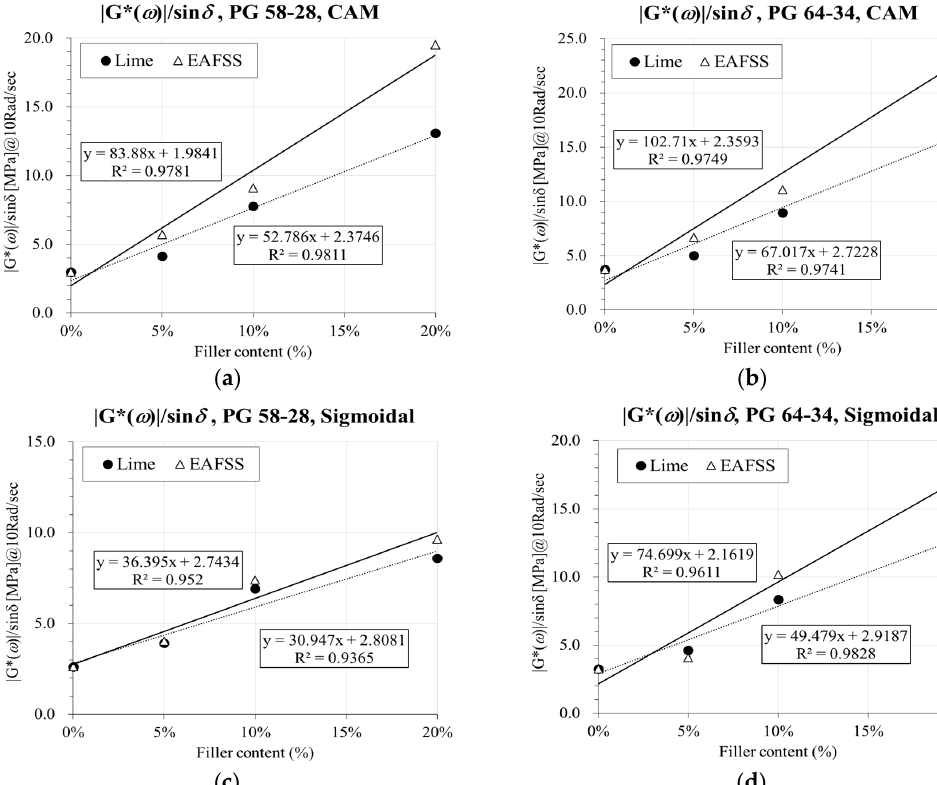
Figure 11. Relation between |G*( ω )|/sin δ and aggregate particle content with CAM [35] and simple Sigmoidal function [45]. ( a ) |G*( ω )|/sin δ , PG 58-28, CAM; ( b ) |G*( ω )|/sin δ , PG 64-34, CAM; ( c ) |G*( ω )|/sin δ , PG 58-28, Sigmoidal; ( d ) |G*( ω )|/sin δ , PG 64-34, Sigmoidal.